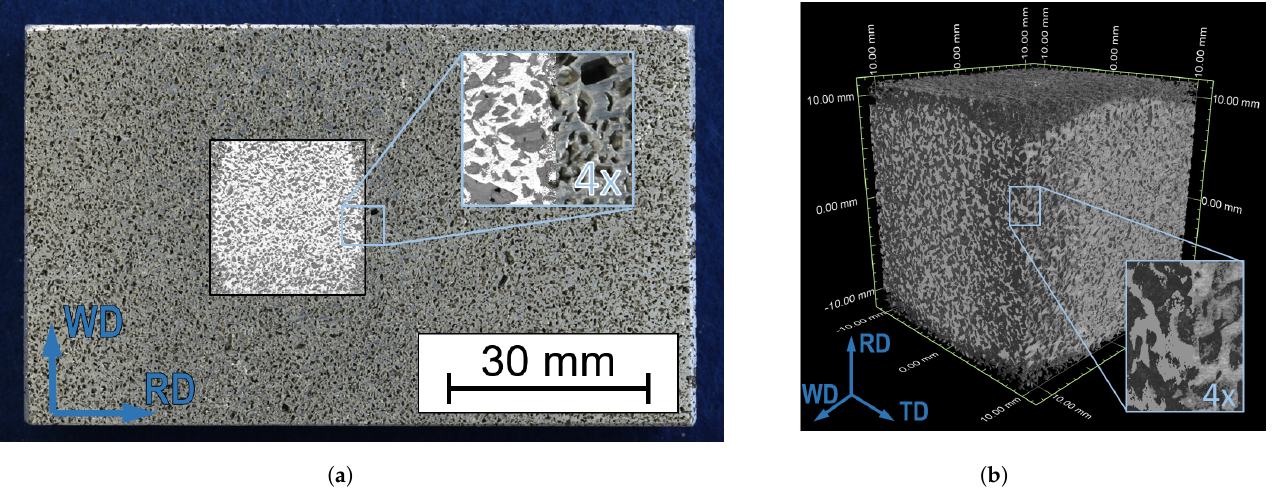
Figure 2. PA80 − 110 (RD: rolling direction, TD: thickness direction i.e., roll gap direction, WD: width direction i.e., roll width direction): ( a ) Macro image of a rolling specimen with superimposed area showing the reconstruction of the associated computed tomography scan. ( b ) three-dimensional CT